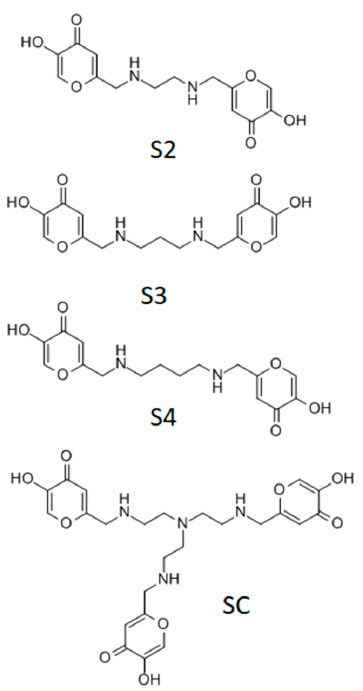
Figure 2. Molecular structure of the ka derivatives studied. S2: [ethane-1,2-diylbis(iminomethanediyl)]bis(5-hydroxy-4H-pyran-4-one), S3: [propane-1,3-diylbis(iminomethanediyl)]bis(5-hydroxy-4H-pyran-4-one); S4: [butane-1,4-diylbis(iminomethanediyl)]bis(5-hydroxy-4H-pyran-4-one); SC: 6,6 ′ ,6 ″ -(((nitrilotris(ethane-2,1-diyl))tris(azanediyl))tris(methylene))tris(3-hydroxy-4H-pyran-4-one).